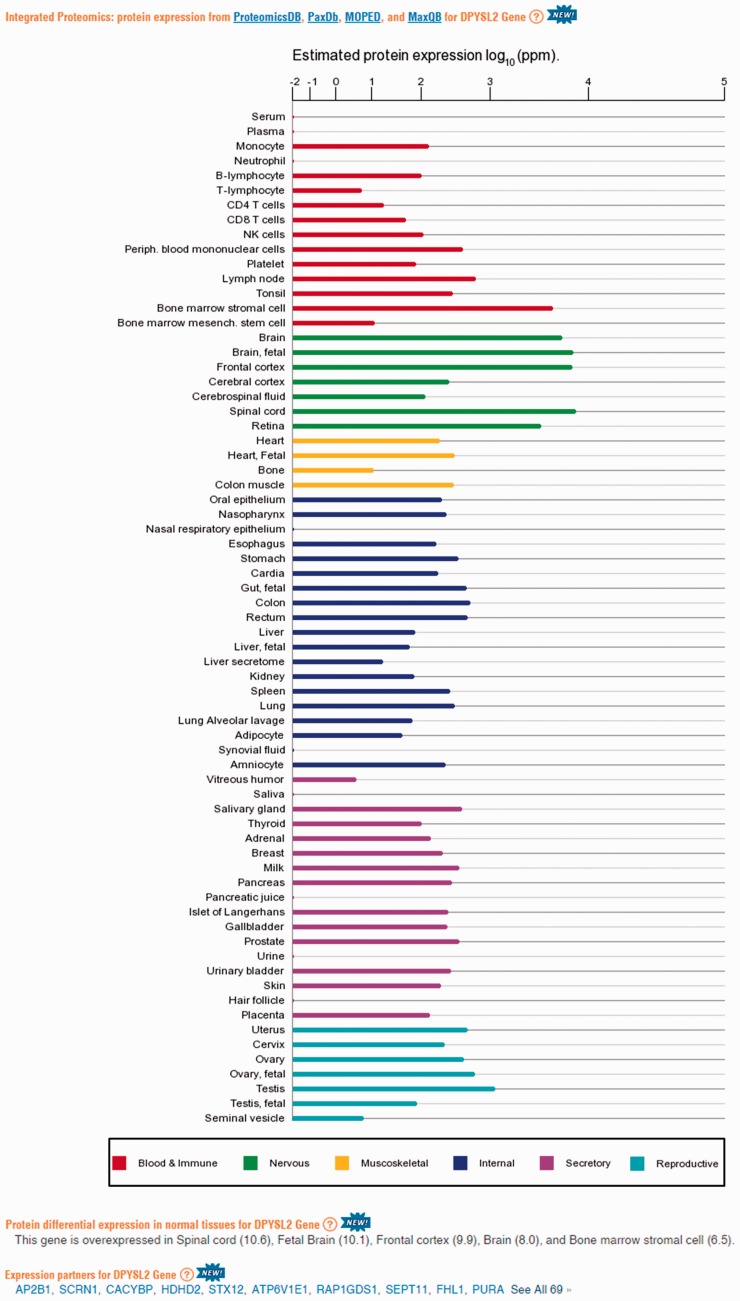
Protein abundance data in GeneCards. A screenshot of protein expression based data for the gene DPYSL2, including (i) protein expression chart; (ii) a list of tissues in which the gene is differentially expressed; (iii) a list of the gene expression partners. DPYSL2 plays a role in neuronal development and polarity, as well as in axon growth and guidance, neuronal growth cone collapse and cell migration (25). Protein expression charts are created via GeneCards automated expression charts pipeline. In order to optimize user perception of the expression, values were displayed using a special root scale (35). This scale enables viewing many orders of magnitude like on a logarithmic scale, but preserves certain characteristics of a linear scale in which the differences increase with the orders of magnitude.